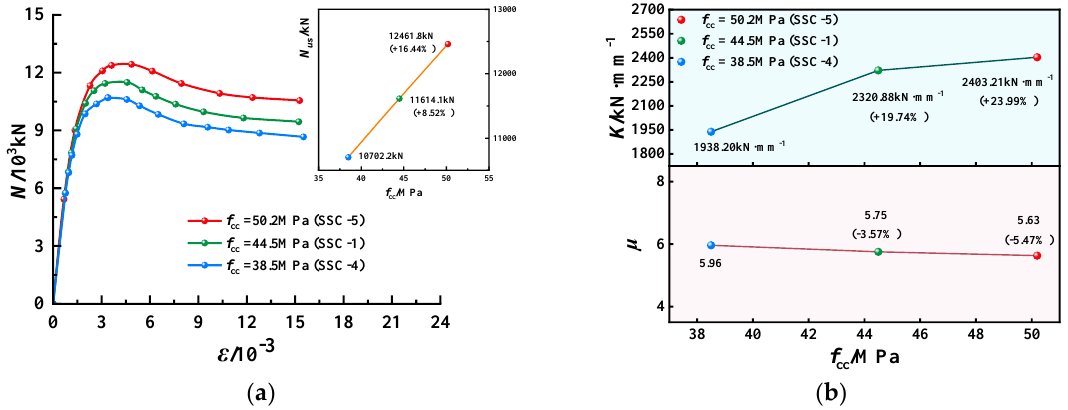
Figure 7. N - ε curves, K and µ of EGCSSCs with different f cc : ( a ) N - ε curves of specimens with cross-section height of 800 mm. ( b ) K and µ of specimens with cross-section height of 800 mm.